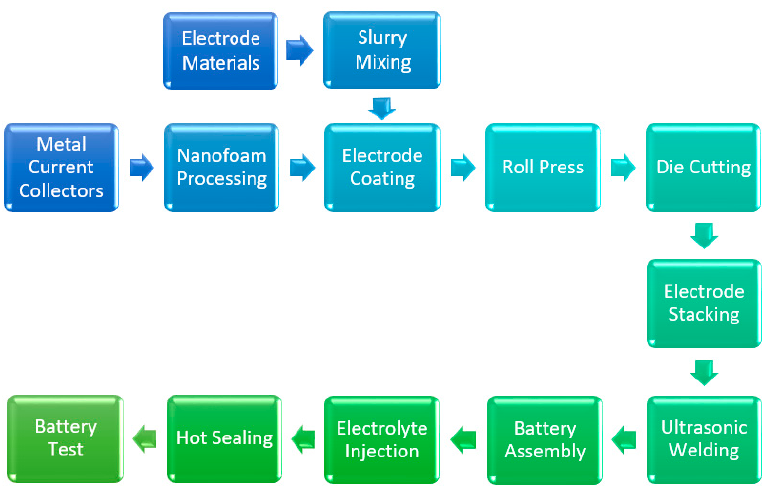
Figure 1. Fabrication process of a high ‐ performance lithium ion battery with nano ‐ porous current